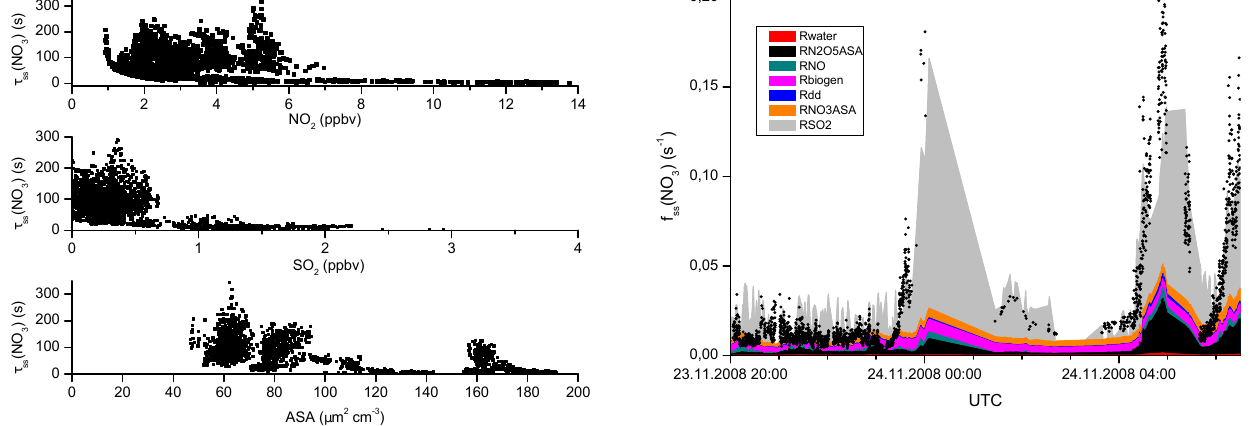
Fig. 8. 23–24 November: dependence of τ ss (NO 3 ) on NO 2 and SO 2 mixing ratios and the aerosol surface area (ASA). τ ss (NO 3 ) was calculated using measurements of N 2 O 5 , NO 2 and O 3 (Eq. 1).